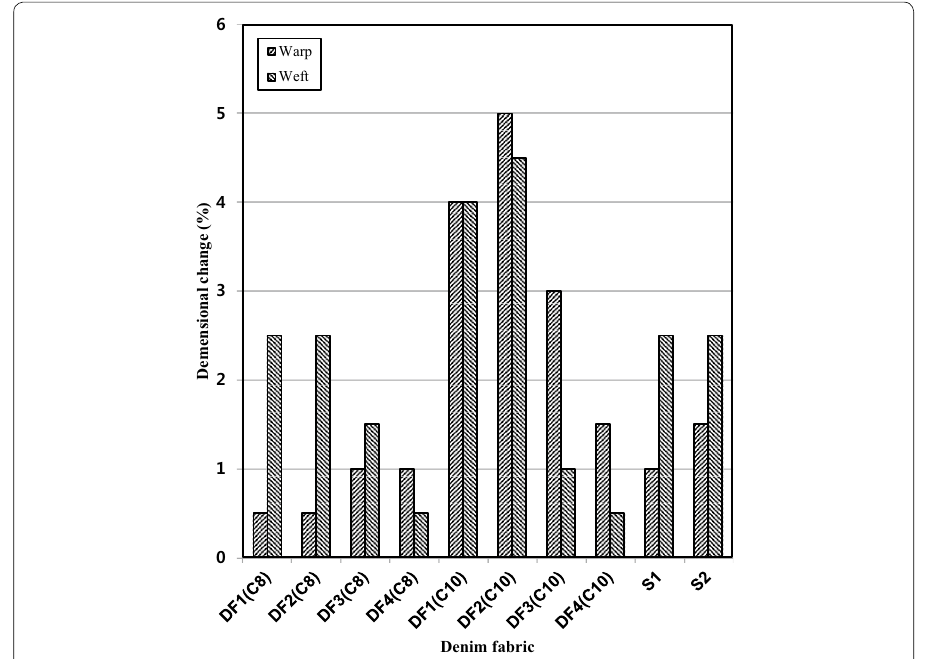
Fig. 5 Dimensional change in washing and drying of Hanji denim fabrics